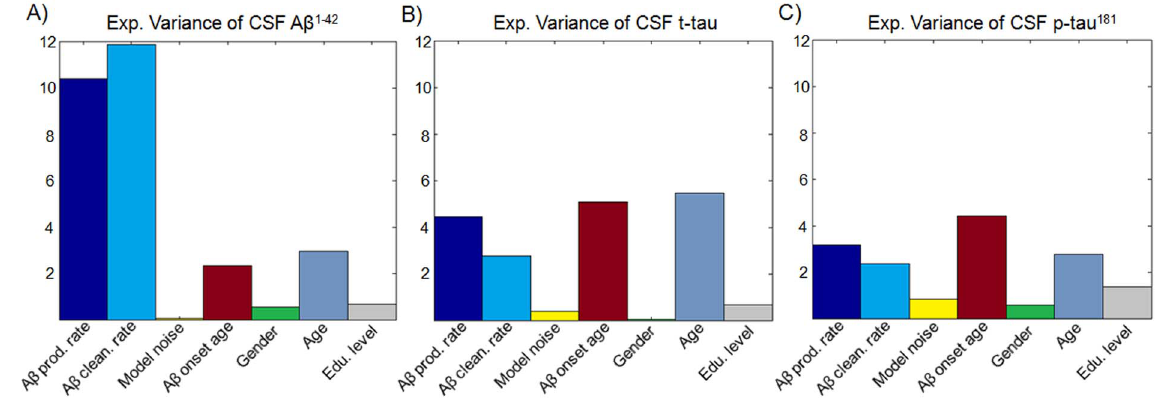
Figure 6. Influence of parameters controlling Aß propagation/deposition on CSF Aß 1-42 , t-tau and p-tau 181 levels. While CSF Aß 1-42 ( A ) is mainly influenced by Aß production/clearance rates, t-tau ( B ) and p-tau ( C ) are highly influenced by chronological age and Aß onset age (combined, these two temporal factors should reflect the interrelation period between amyloid pathophysiology and tauopathy).